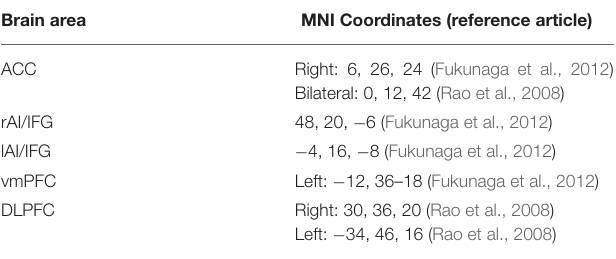
FIGURE 3 | MRI T1 weighted images. The yellow area in the images above shows anterior insula. Results are represented with p < 0.05 with multiple